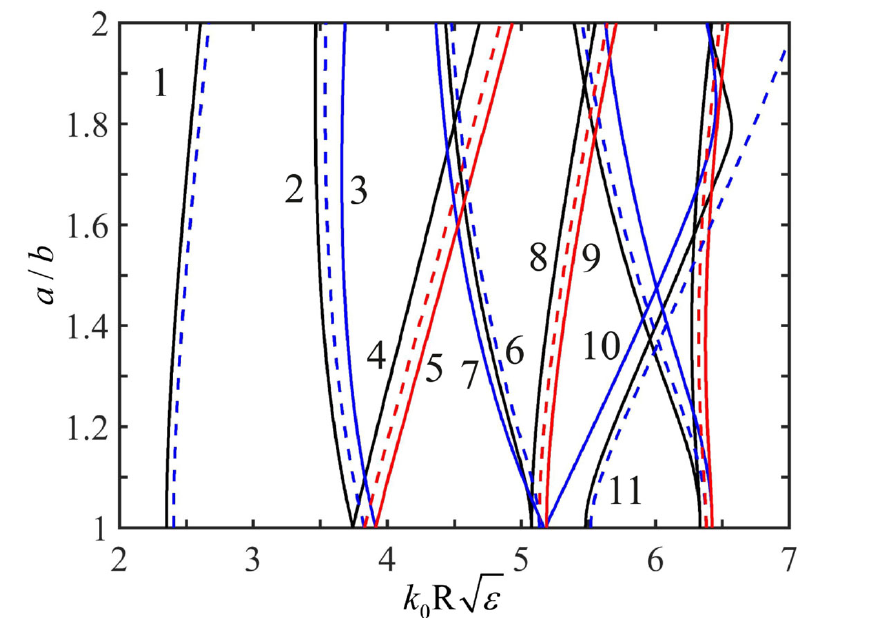
Figure 6. Dependence of the size parameter k 0 R ε of the perfect invisibility modes of TM type (PTM) on the shape parameter of the ellipse, a / b at ε = 50. Solid blue curves are the solution of Equation (30), and solid red curves are the solutions of Equation (31). Blue and red dashed curves correspond to the confined modes (7), which arise in an elliptical waveguide with perfect magnetic walls. Solid black lines correspond to the quasi-normal TM modes. The modes are marked with the numbers: 1—TMc 01 , 2—TMc 11 ; 3—PTMc 11 ; 4—TMs 11 ; 5—PTMs 11 ; 6—TMc 21 ; 7—hybrid mode PTMc 02,1 ; 8—TMs 21 ; 9—PTMs 21 ; 10—hybrid mode PTMc 20,1 ; 11—TMc 02 .